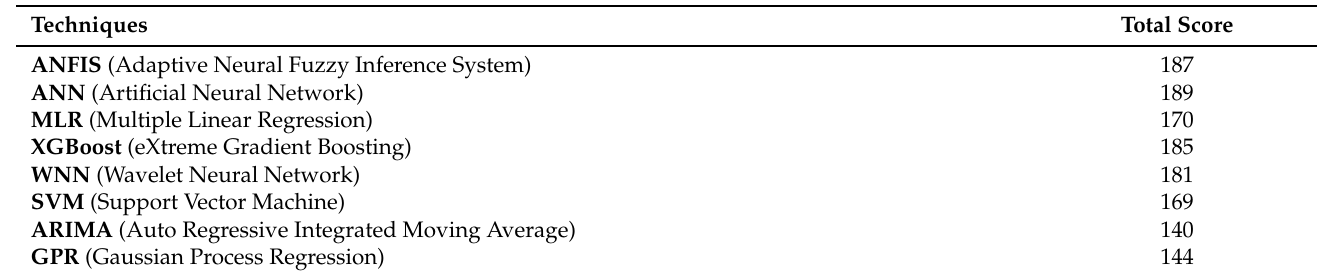
Table 2. MCA total scoring